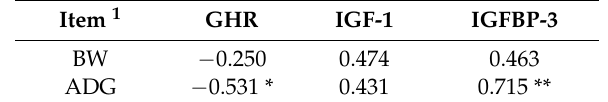
Table 5. Pearson correlation coefficient between relative genes expression and growth performance in